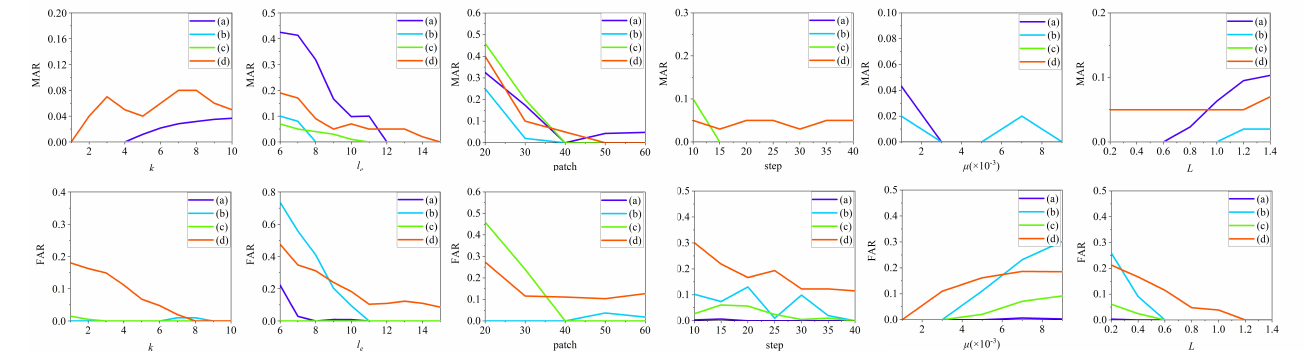
Figure 8. Relationship between key parameters of the proposed method and FAR and MAR.